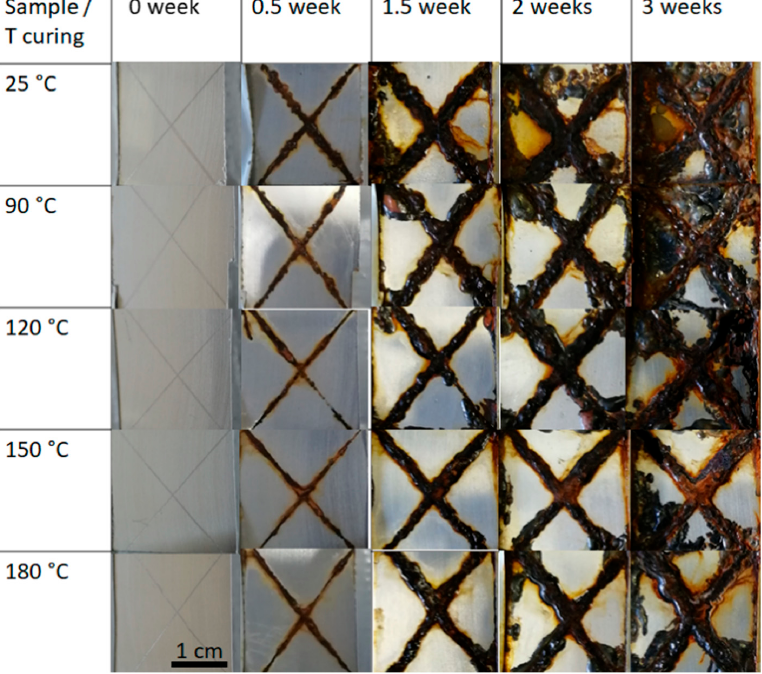
Figure 7. Images of structural steel samples coated with PBMA-siloxane coatings and cured at se- lected temperatures after 0, 0.5, 1.5, 2 and 3 weeks of salt spray test (ASTM B117) to monitor corro- sion propagation (dark brown colour). Samples were scribed before exposure. The withdrawal rate was 2.3 mm/s.